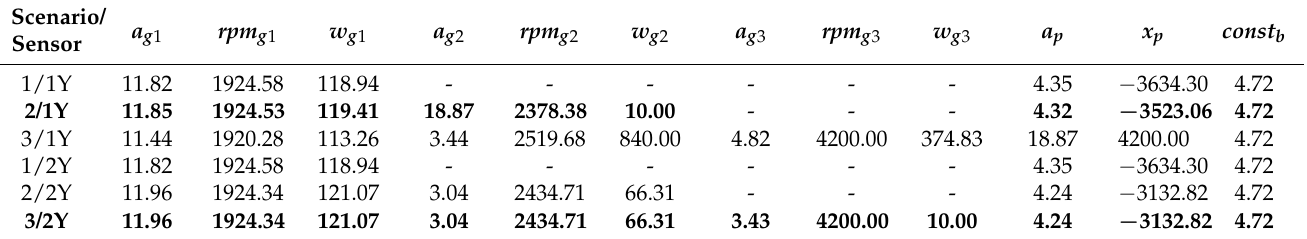
Table 6 . Parameters of the decomposed functions identified by the DE algorithm and chosen by the MD3 method based on the reference data and the MSE as the quality index.